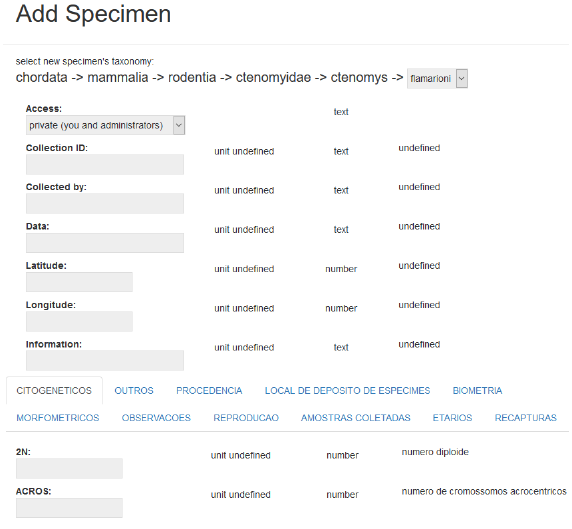
Figure 8. Form for entering data describing a new specimen. Attributes such as the collection ID and geographical location are common for all species. Other attributes are inherited from the species description. Values for these attributes uniquely describe the specimen being